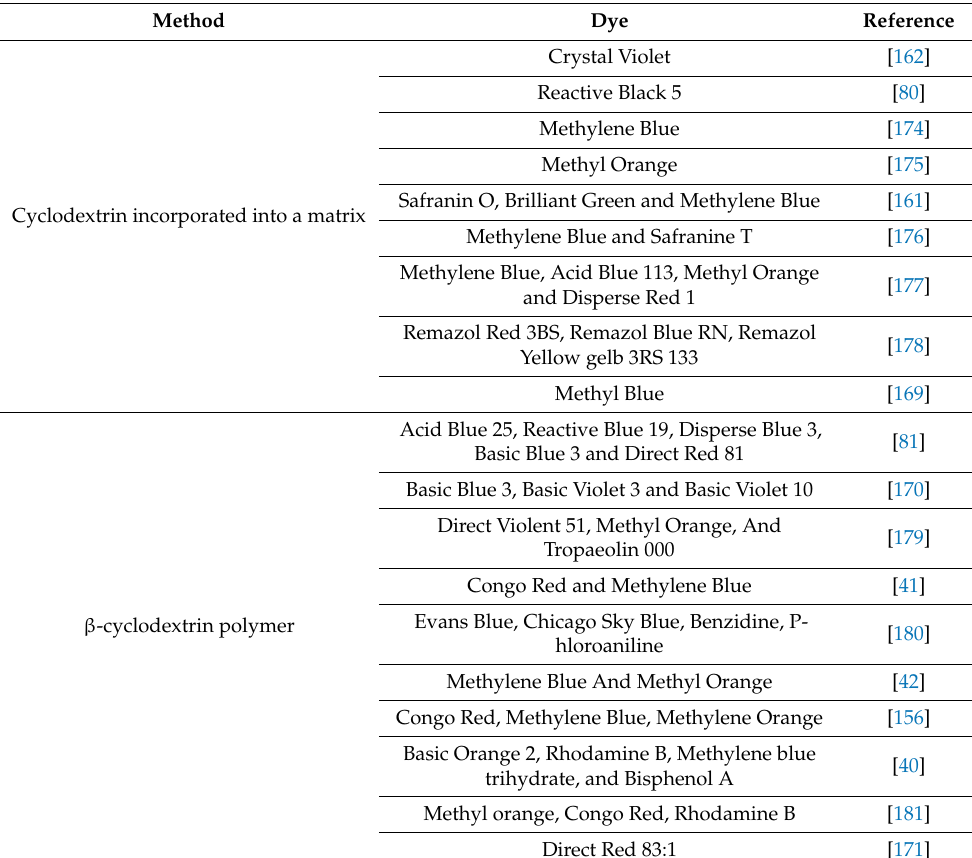
Table 4. Use of cyclodextrins as a removal agent in the textile process.